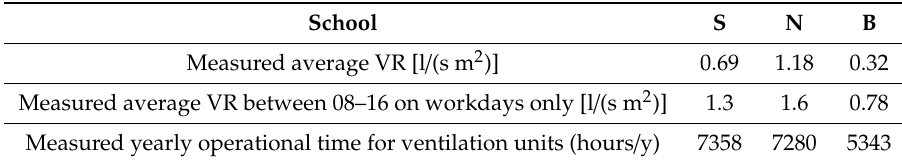
Table 5. Measured average VRs for whole days and nights, average VRs between 08–16 on workdays and yearly ventilation operational times. The area m 2 in the table refers to A temp . The measurements of VRs and ventilation operational times were described in previous publications by Simanic et al. [11,22]. SFP values were defined during the design phase. Reproduced from [11,22], Journal of Building